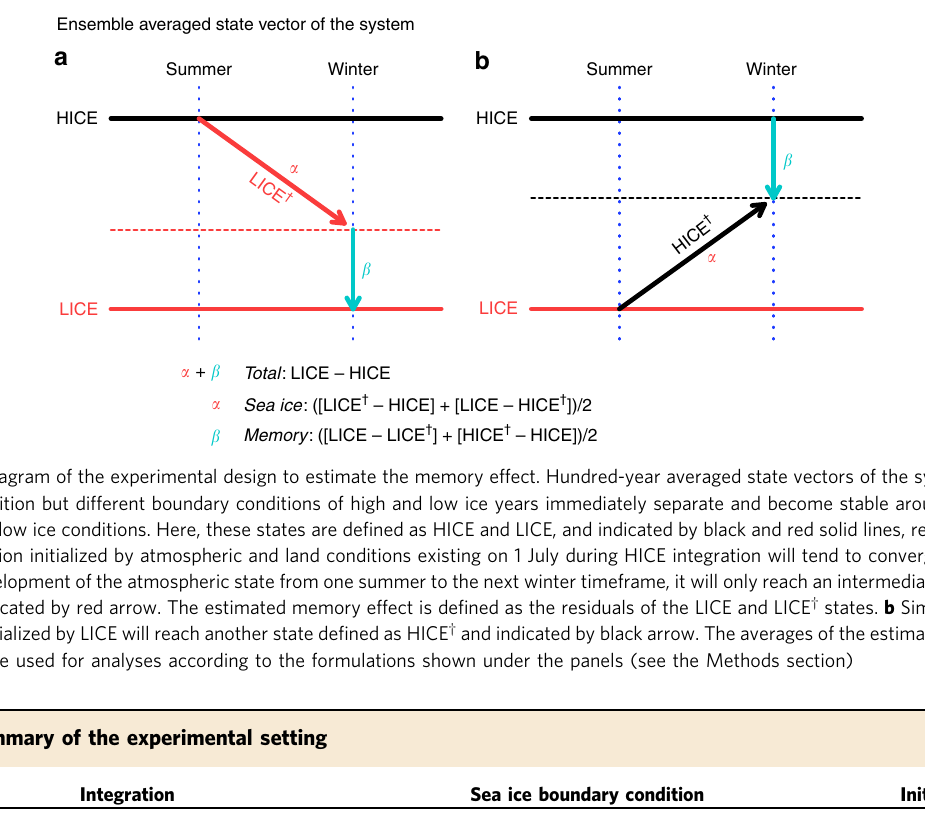
Table 1 Brief summary of the experimental setting Run